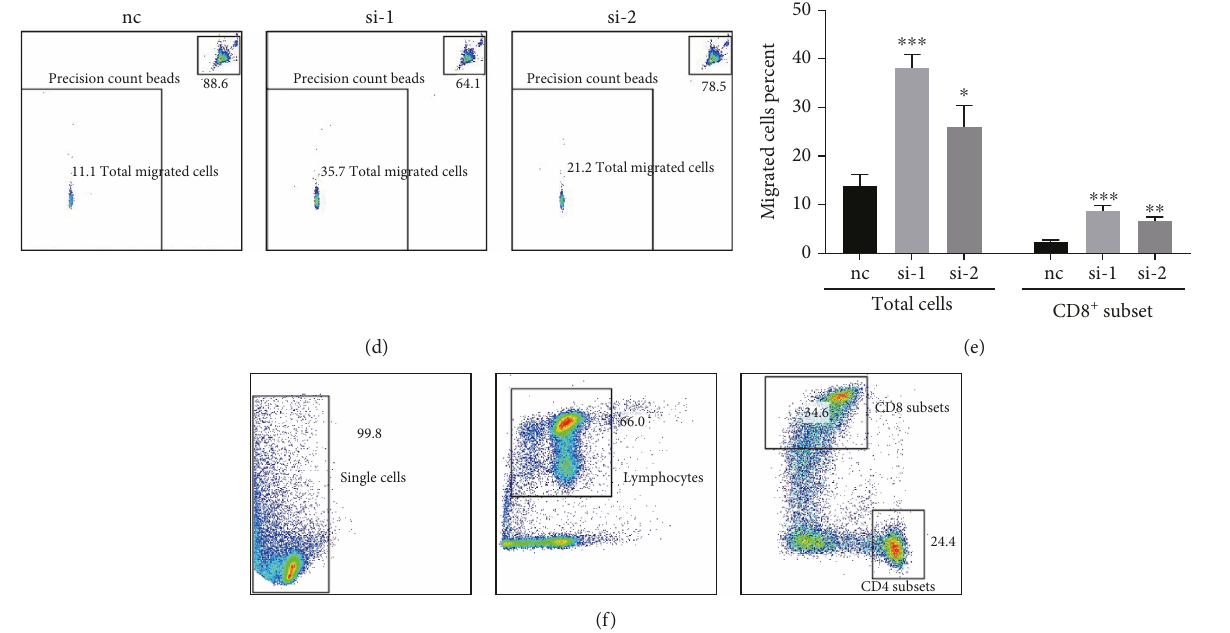
Figure 4: DKK2 impacted the in fi ltration capability of immune cells. (a) Gene set enrichment analysis of DKK2 showed the potential relationship between DKK2 and PDAC immunity invasion. (b) Representative immunohistochemical samples of DKK2, CD8A, FOXP3, GATA3, and T-bet in PDAC tissue microarray. (c) Patients were divided into two groups according to the expression of DKK2, and the column bar graphs showed the correlation between CD8A, FOXP3, GATA3, T-bet, and DKK2. (d) PBMCs treated with siRNA were performed with migration assay and then were counted by fl ow cytometry, and the percent was displayed by the bar graph (e). (f) Representative fl ow cytometry pro fi les of T cell subtype were shown. CD4 + and CD8 + cells, which were gated on single cells and lymphocytes, were gated as depicted. Signi fi cant di ff erences are indicated as ∗ P < 0 05 , ∗∗ P < 0 001 , and ∗∗∗ P < 0 0001